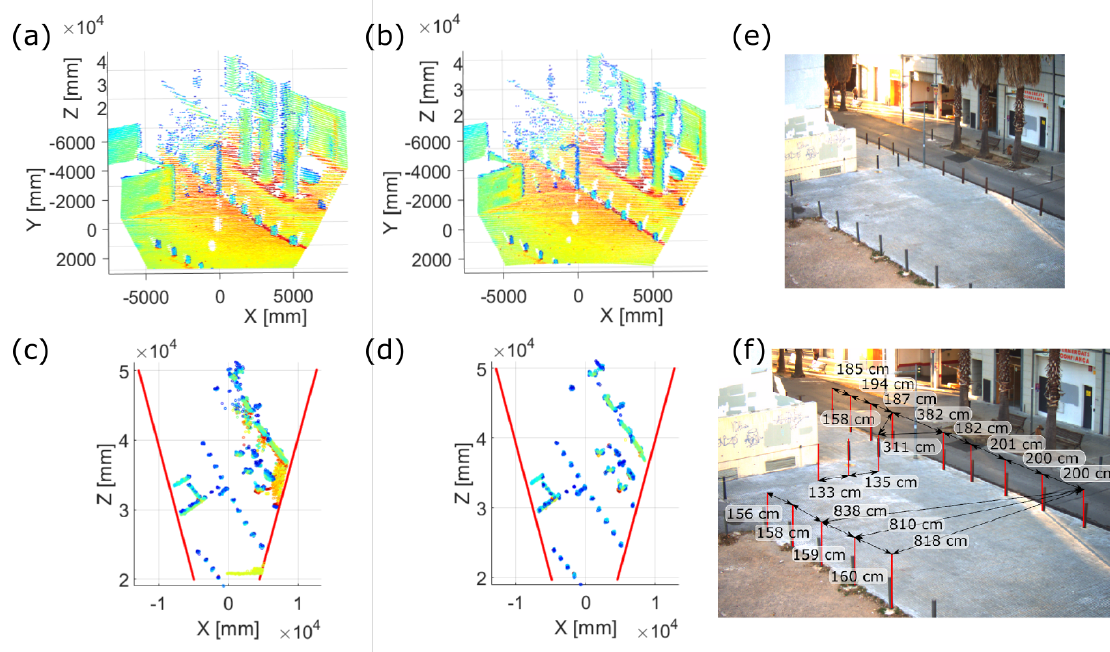
Figure 15. 30 × 20 ◦ FOV prototype point clouds of ( e ) the scenario. ( a ) Previous calibration point cloud. ( b ) Presented calibration point cloud. ( c ) and ( d ) Orthogonal projection on the ground plane of ( a ) and ( b ) respectively. ( f ) Measured distances between road pins taken as the ground